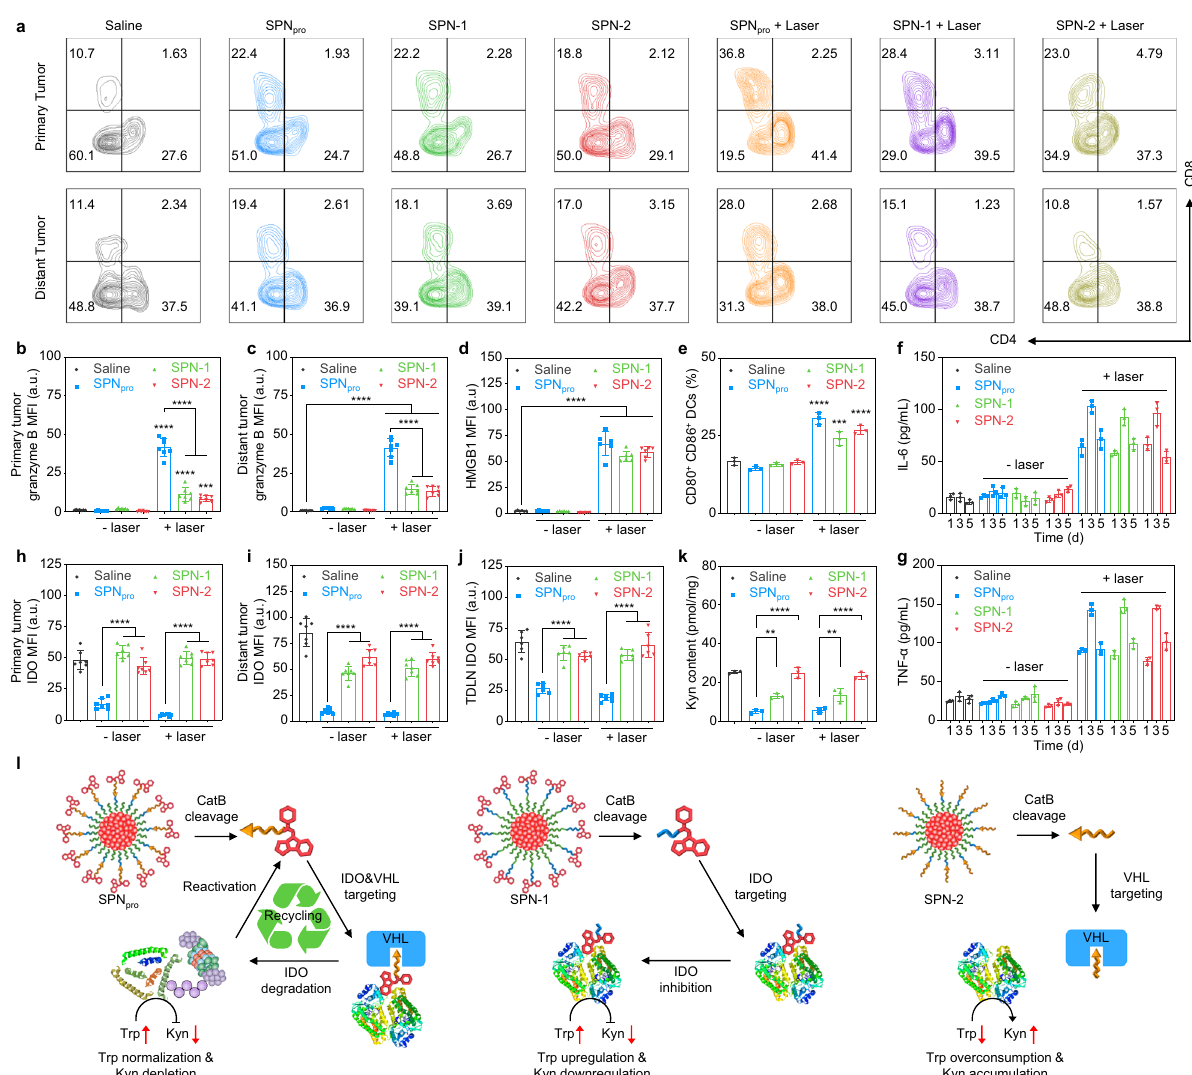
Fig. 5 In vivo SPN pro -mediated activatable photo-immunometabolic therapy. a FACS assay of tumor-in fi ltrating T lymphocytes (CD8 + and CD4 + ) of the primary and distant tumors in 4T1-tumor-bearing mice after different treatments. 4T1-tumor-bearing mice were intravenously injected with saline, SPN pro , SPN-1, or SPN-2 (200 μ L, [PCB] = 200 μ g/mL), and the primary tumors were treated with or without NIR photoirradiation (0.3 W/cm 2 at 808 nm) for 6 min. Quanti fi cation of granzyme B expression in primary ( b ) and distant ( c ) tumor tissues of 4T1-tumor-bearing mice ( n = 7). p < 0.0001; Saline versus SPN-2 + laser: p = 0.0004 for primary tumors ( b ). p < 0.0001 for distant tumors ( c ). d Quanti fi cation of HMGB1 expression in the tumor tissues of 4T1- tumor-bearing mice by confocal fl uorescence images after different treatments ( n = 6). p < 0.0001. e Quanti fi cation of matured DCs (CD80 + and CD86 + ) from the tumor-draining lymph nodes (TDLNs) in 4T1-tumor-bearing mice after different treatments ( n = 3). p < 0.0001; Saline versus SPN-1 + laser: p = 0.0002. In vivo cytokine detection of TNF- α ( f ) and IL-6 ( g ) in sera from mice after different treatments at different timepoints (1, 3, and 5 days) ( n = 3). h – j Quanti fi cation of IDO expression in primary tumors ( h ), distant tumors ( i ), and TDLNs ( j ) of 4T1-tumor-bearing mice by immuno fl uorescence staining after different treatments ( n = 7). p < 0.0001. k The Kyn content in primary tumors of 4T1-tumor-bearing mice after different treatments ( n = 3). p < 0.0001; SPN pro versus SPN-1: p = 0.0038; SPN pro + laser versus SPN-1 + laser: p = 0.0041. l Schematic illustration of the mechanisms of SPN pro -, SPN-1-, and SPN-2-mediated IDO degradation and Trp-metabolism intervention. Statistical signi fi cance in b , c , d , e , h , i , j , and k was calculated via one-way ANOVA with a Tukey post-hoc test. * p < 0.032, ** p < 0.0021, *** p < 0.0002, and **** p < 0.0001. The mean values and SD are